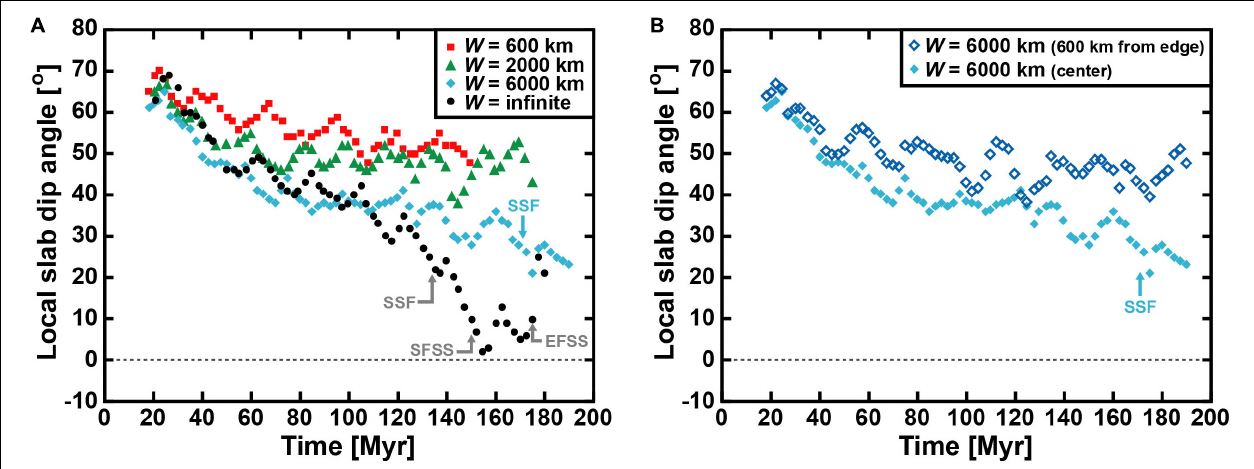
FIGURE 5 | Slab dip angle evolution of geodynamic models of progressive subduction in which the width ( W ) of the subduction zone is varied [narrow slab model with W = 600 km, intermediate-width slab model with W = 2000 km, wide slab model with W = 6000 km, and very wide slab model with W = infinite (2D set-up)]. The diagrams show the temporal evolution of the minimum slab dip angle for a local, 100-km-long, slab segment within the depth range 100–200 km to determine the flat slab subduction stage, which is defined as the time when the local slab dip is ≤ 10 ◦ . (A) Model results for the four different models for sections located in the center of the subduction zone. The narrow and intermediate-width slab models show no flat slab development. The wide slab model shows the onset of slab flattening in a late stage of the subduction process ( ∼ 171 Myr), with the development of a concave-upward hinge in the slab at ∼ 100–150 km depth. For the very wide slab model, the onset of slab flattening occurs earlier ( ∼ 134 Myr) and flat slab subduction occurs in a late stage of subduction at 150–175 Myr with a brief intermittent period of ∼ 4 Myr where the local slab dip exceeds 10 ◦ . (B) Model results of the wide slab model for one section located at 600 km from the nearest lateral slab edge and one section through the center of the subduction zone (3000 km from the lateral slab edges). The section near the lateral slab edge retains a relatively steep slab dip angle and shows no sign of slab flattening, in contrast to the central section. SSF-Start of slab flattening; SFSS-Start of flat slab subduction; EFSS-End of flat slab